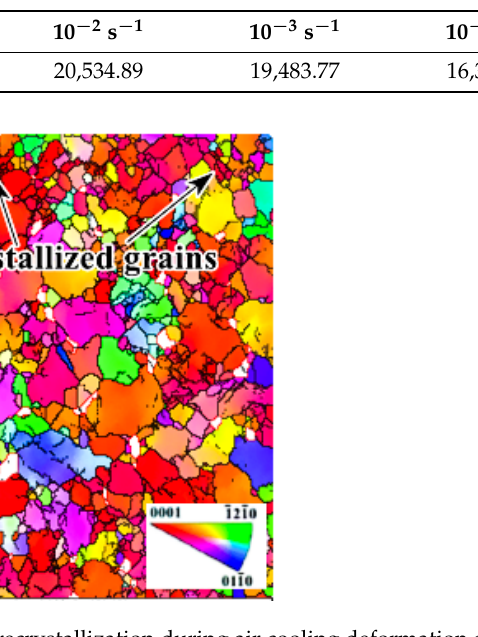
and 1/T. 𝑙𝑙𝑛𝑛 [sinh ( 𝛼𝛼𝜎𝜎 )]